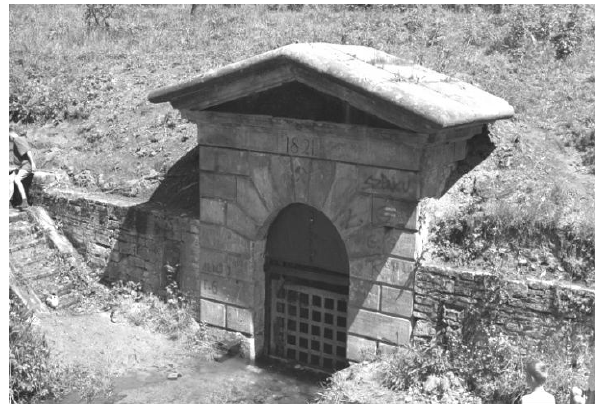
Fig. 2. The reclaimed terrains in the mining subsidence area along Szarlejka Valley ( F. Wieland